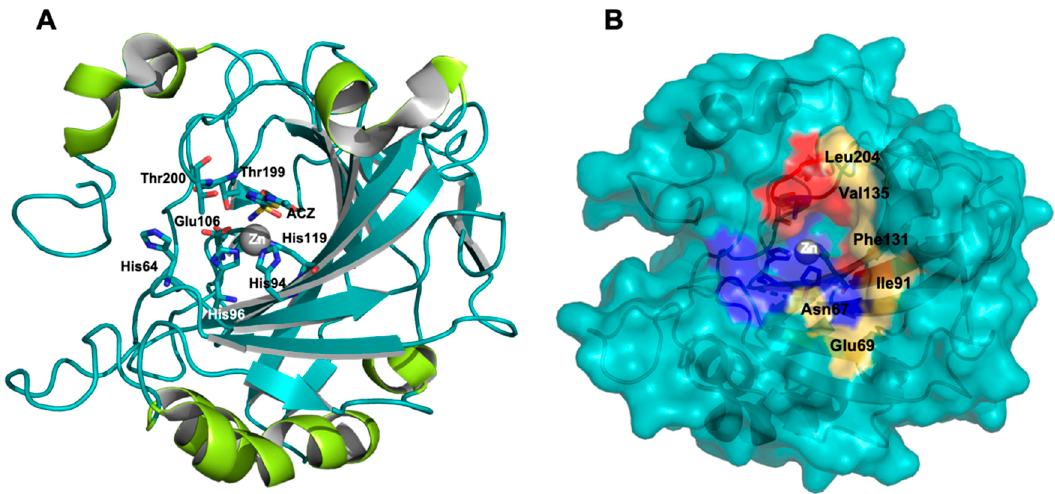
Figure 3. Graphical representation of CA II (pdb id 3HS4). ( A ) CA II in complex with ACZ, α -helices are colored in lemon. ( B ) Protein surface of CA II, hydrophobic residues of catalytic site are colored in red, hydrophilic residues are colored in blue while the unique amino acid residues of CA II are highlighted yellow–orange and labeled.